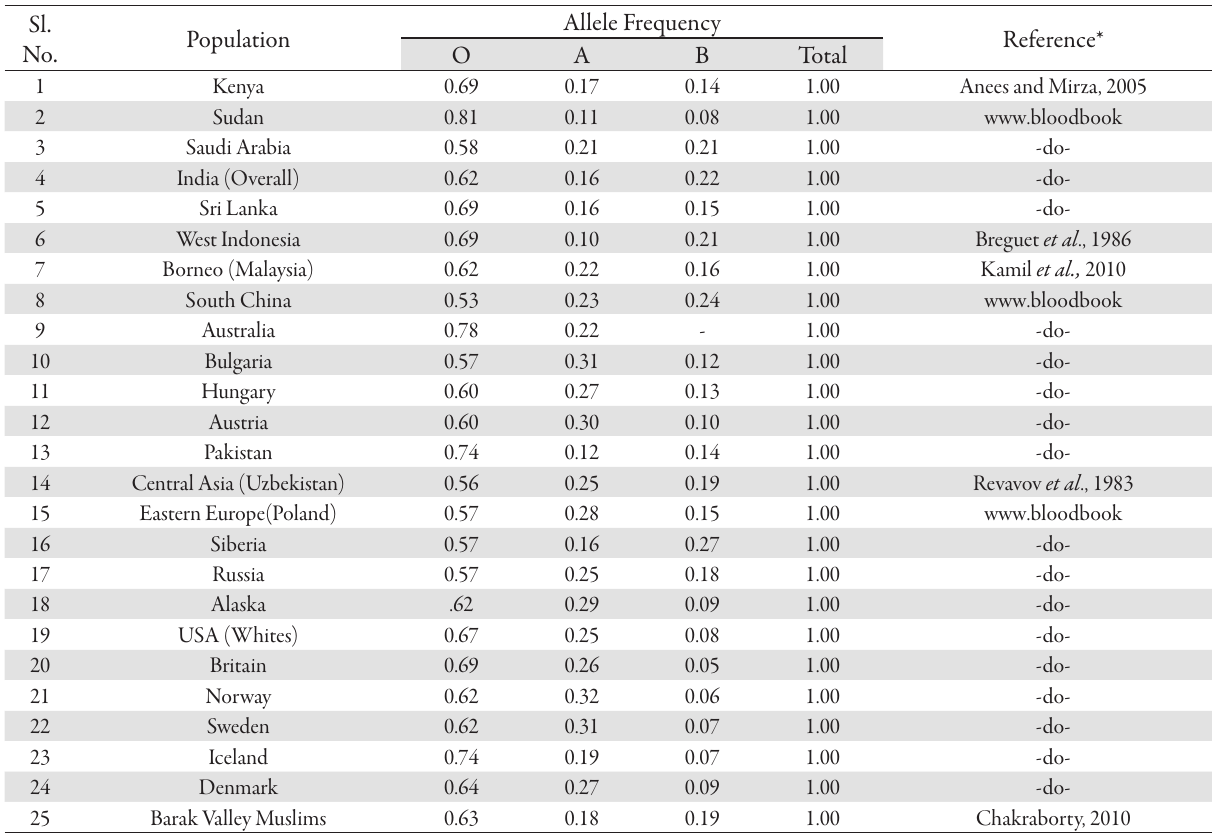
Tab. 1. Estimates of allele frequencies of ABO gene in Barak Valley Muslims (BVM) and other 24 populations/nations